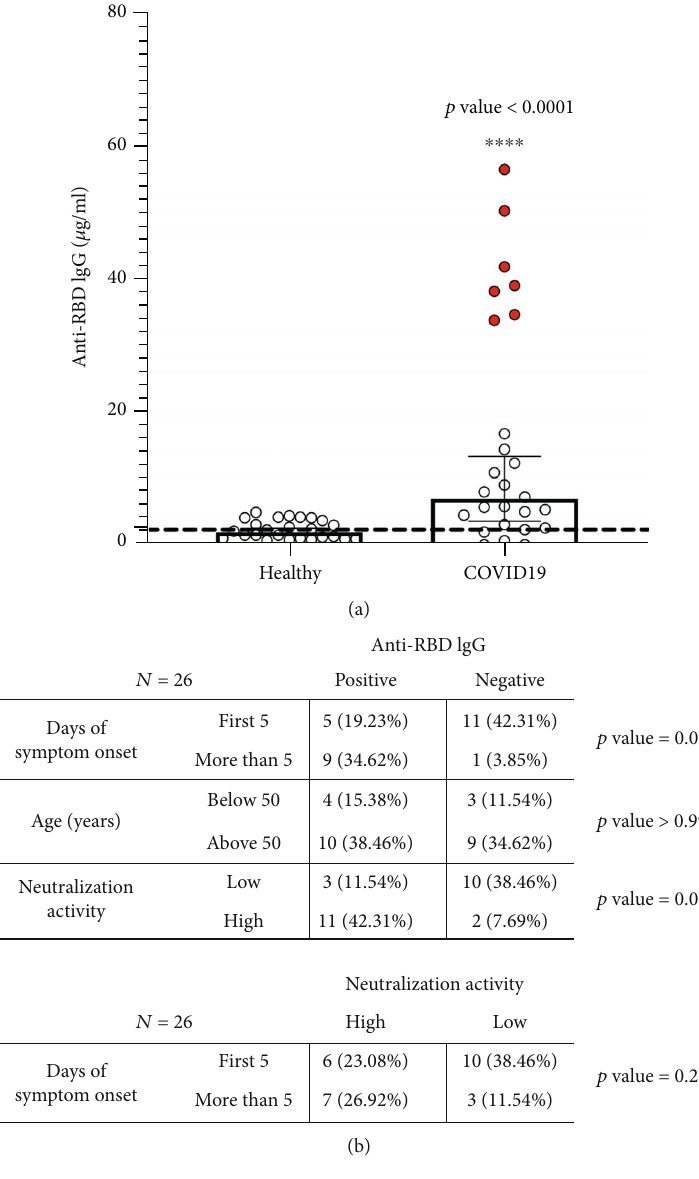
Figure 4: Anti-RBD IgG antibodies and neutralization activity during active infection with SARS-CoV-2. (a) Anti-RBD IgG levels in participants, namely, healthy controls as the baseline group ( N = 25 ) and active COVID-19 patients with di ff erent degrees of severity ( N = 26 ). (b) 2 × 2 contingence analysis for positive/negative antibody levels and days of symptom onset, age (years), neutralization activity and for high/low neutralization activity (median ID80) and days of symptom onset. 75th percentile (P75) is indicated in red circles, and IgG cut-o ff is indicated by a black dashed